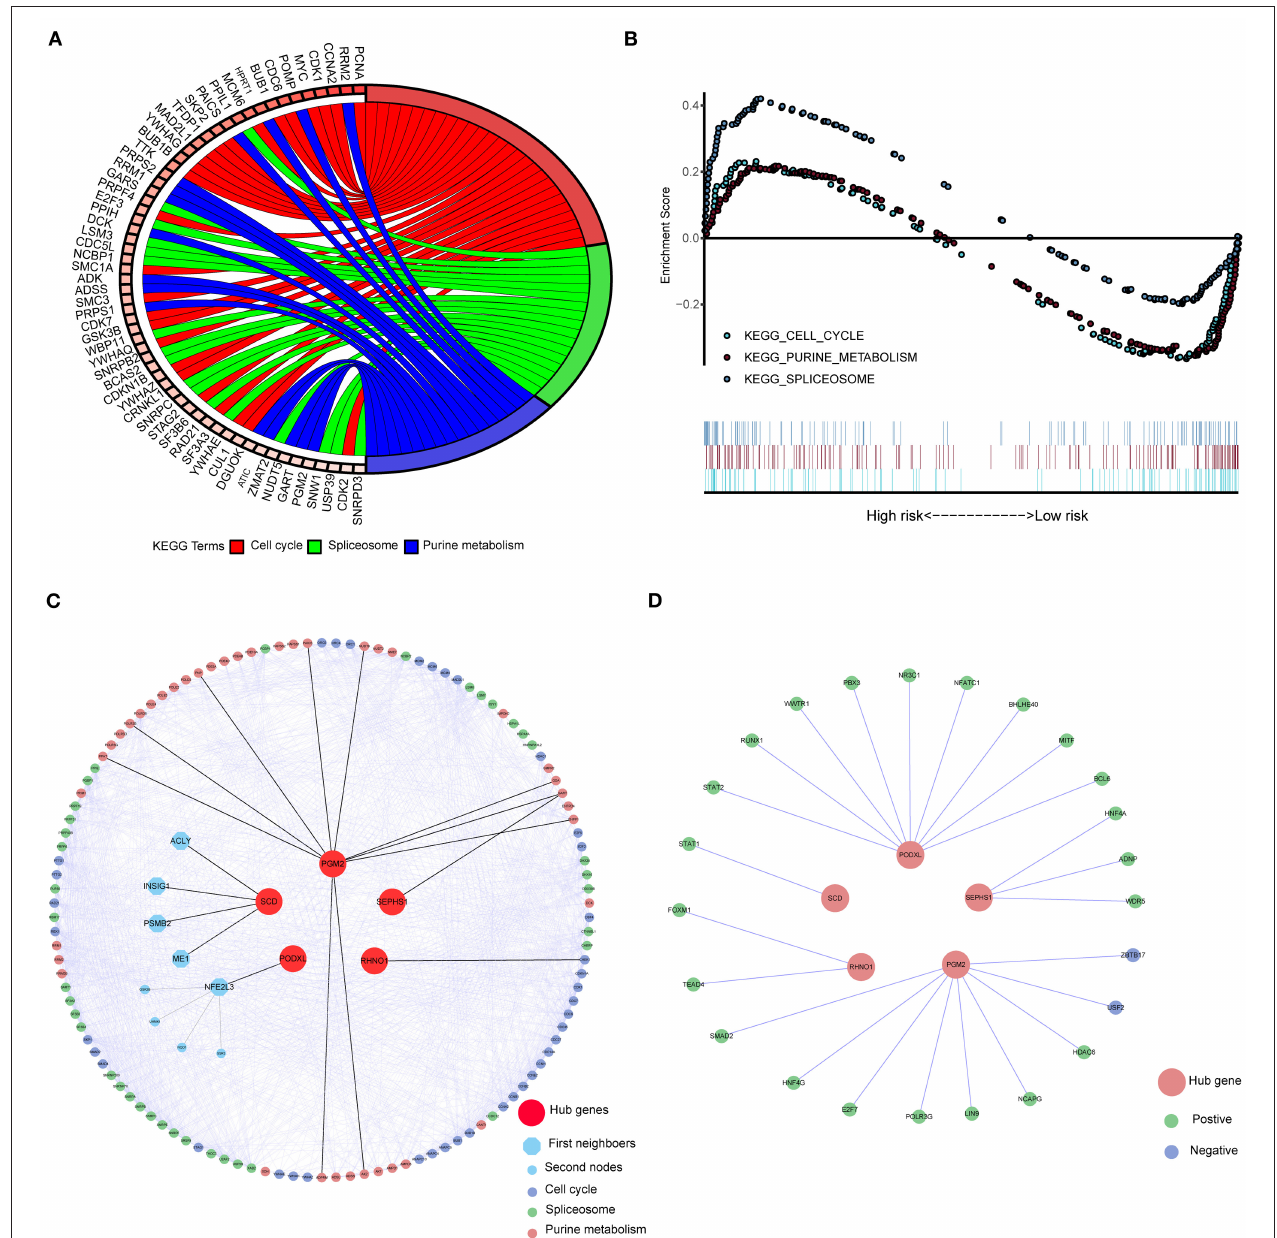
FIGURE 4 | The signaling pathways of five hub genes implicated in CRC were evaluated by the KEGG pathway enrichment analysis. (A) The enriched pathways of CRC related genes in KOBAS 3.0 ( p < e − 8 ) with the KEGG over-representation test. (B) The shared pathways of GSEA between high- and low-risk groups according to the threshold of FDR < 25% and p < 0.05. (C) The molecular connections among five hub genes and key pathways through PPI and shortest path analysis. (D) Five Hub genes interacted with differently expressed TFs. KEGG, Kyto Encyclopedia of Genes, and Genomes; TFs, Transcription factors; PPI, Protein-protein interaction; GSEA, Gene Set Enrichment